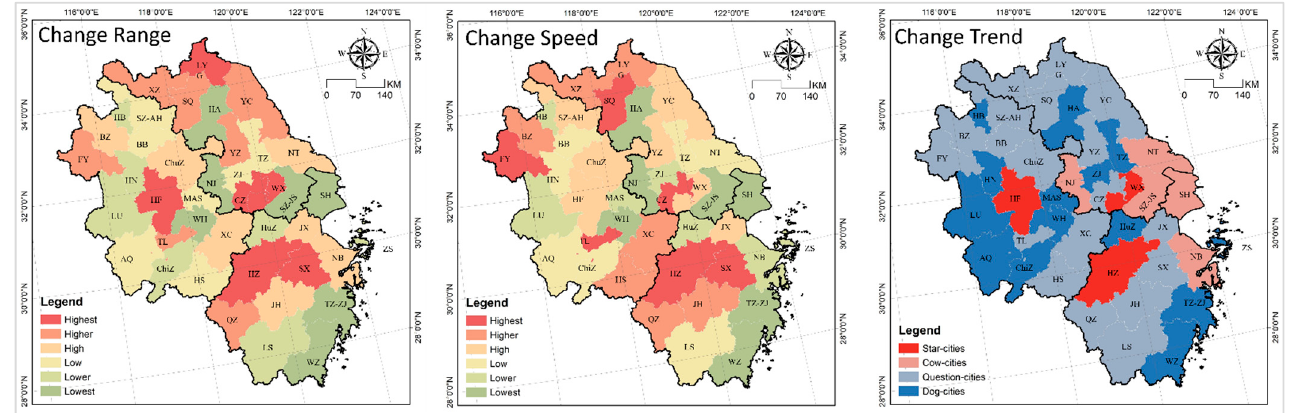
Figure 9. Spatial pattern analysis on changes in urban industrial land in the YRD.